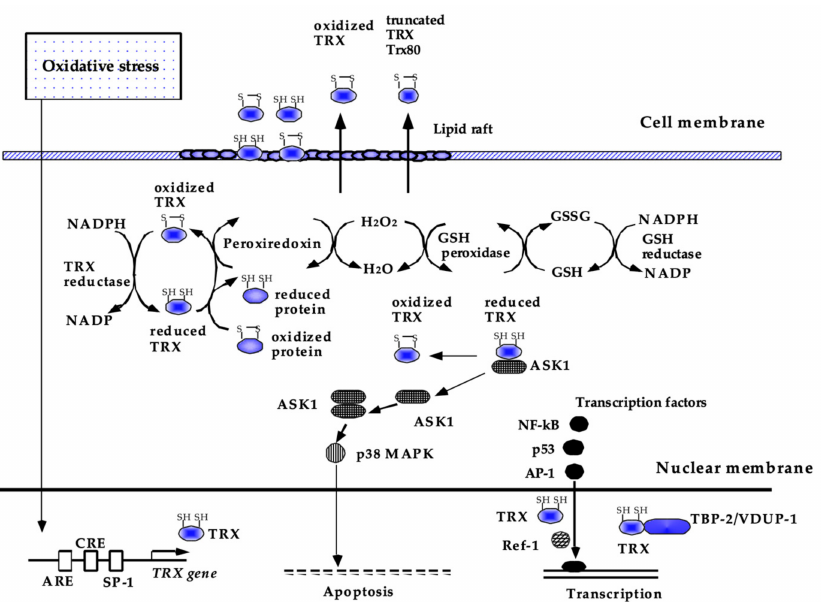
Figure 3. Current understanding of the biological functions of TRX. Thioredoxin (TRX) is a redox- acting protein that exchanges disulfide to dithiol to maintain the reducing status of various molecules. In the cytoplasm, TRX acts as a radical scavenger, either by itself or in cooperation with peroxiredoxin. TRX also has antiapoptotic and anti-inflammatory effects, some of which are attributed to the regulation of intracellular signal transduction, such as ASK-1 and p38 MAPK, and DNA binding of NF-kB, AP-1, and p53. TRX is ubiquitously present in the human body and is also inducible by a wide variety of stress conditions via the modulation of transcription factor binding to its promoter region. This figure has been reproduced with permission from the authors